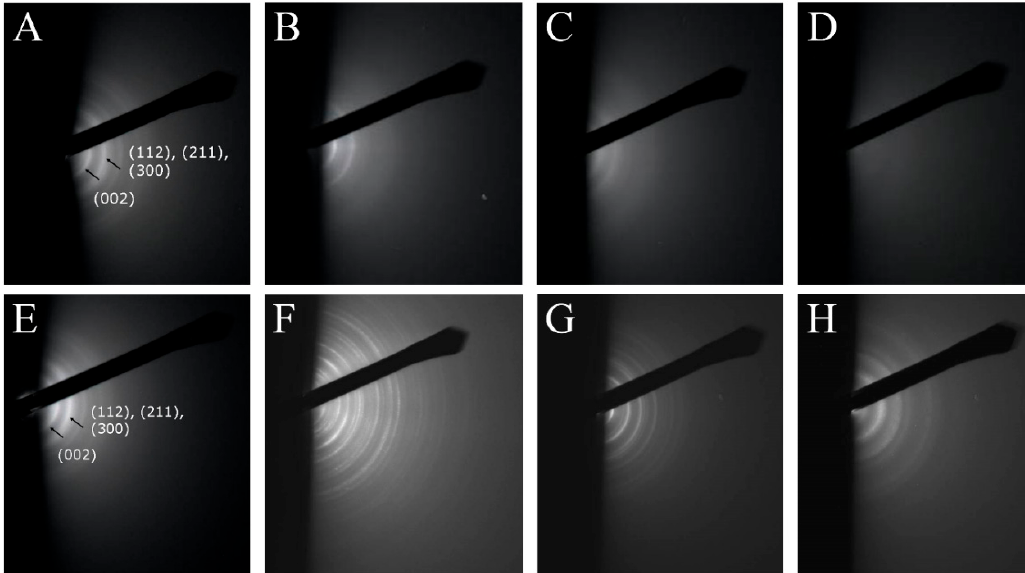
Figure 4. RHEED diffraction patterns of HA and SiHA thin films sputtered onto CPTi discs and annealed at 600 °C and 700 °C for A-D and E-H, respectively. Images were obtained at 200 keV. ( A ) and ( E ) HA, ( B ) and ( F ) SiHA1, ( C ) and ( G ) SiHA2 and ( D ) and ( H ) SiHA3.